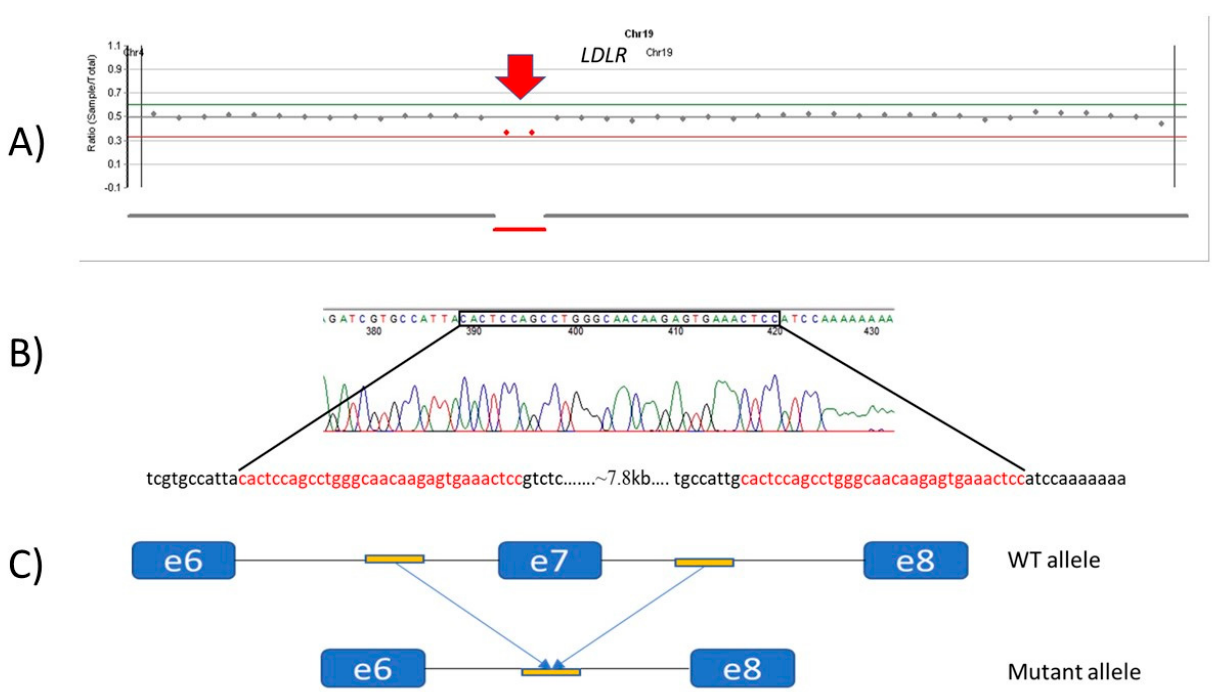
Figure 3. Breakpoint determination of the deletion of exon 7. ( A ) Coverage-based CNV from NGS data. The red arrow indicates the complete heterozygous deletion of exon 7 covered by 2 amplicons (Patient 12). ( B ) The result of Sanger sequencing of the mutant allele amplified by the PCR reaction. The short homologue DNA sequence is highlighted in the frame and highlighted in red. ( C ) The wild-type and mutant allele without exon 7. The mutant allele contains only one copy of a short homologue DNA sequence.